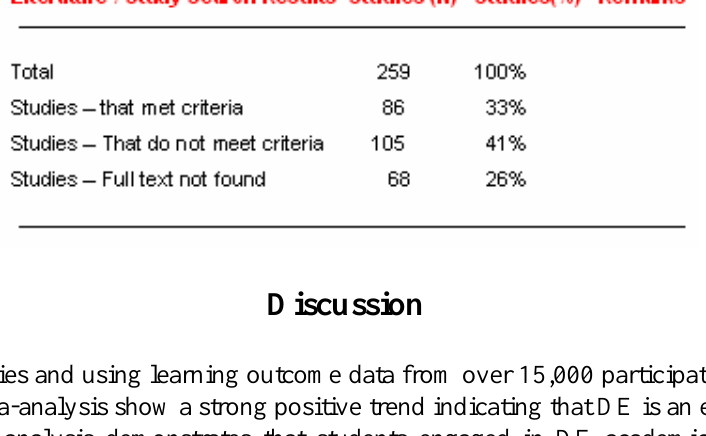
Table 2. Summary of Study